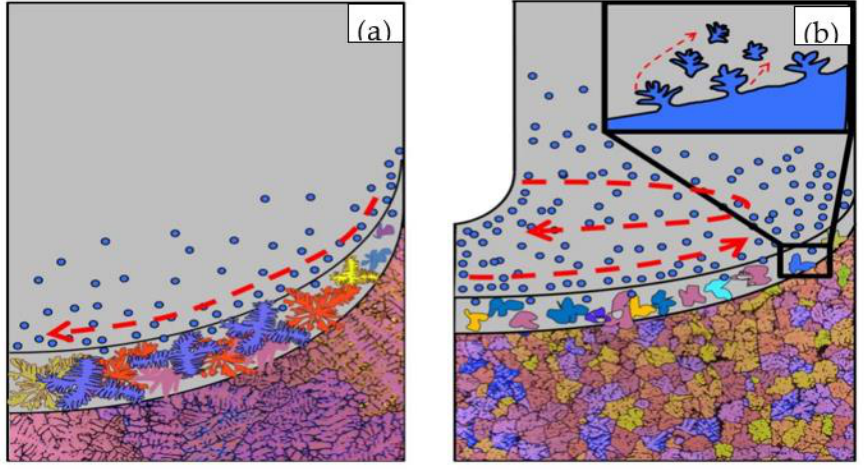
Figure 5. The Schematic diagram showing grain nucleation and growth of NDC ( a ) and UDC ( b ) casting.